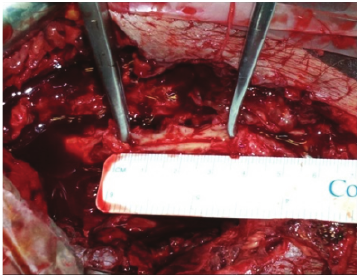
Figure 1: After proximal and distal control, careful dissection of the common femoral and external iliac artery revealed a 3cm longitudinal arterial defect.